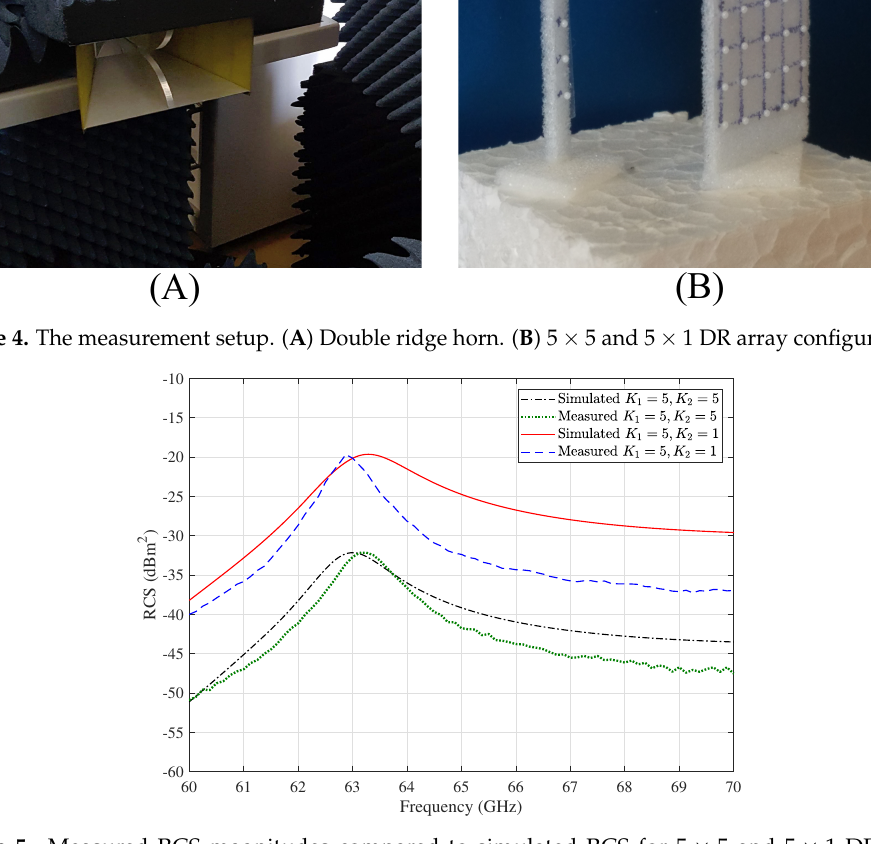
Figure 5. Measured RCS magnitudes compared to simulated RCS for 5 × 5 and 5 × 1 DR array